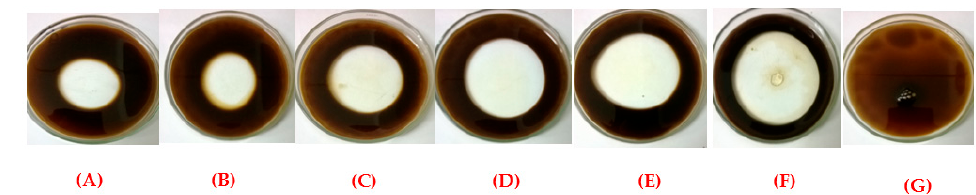
Figure 4. Dispersion of burnt engine oil in seawater by bioemulsifier produced by C. lipolytica UCP 0988 in accordance with the factorial design: ( A ) Assay 1; ( B ) Assay 2; ( C ) Assay 3; ( D ) Assay 4; ( E ) central point; ( F ) SDS; and ( G ) water.